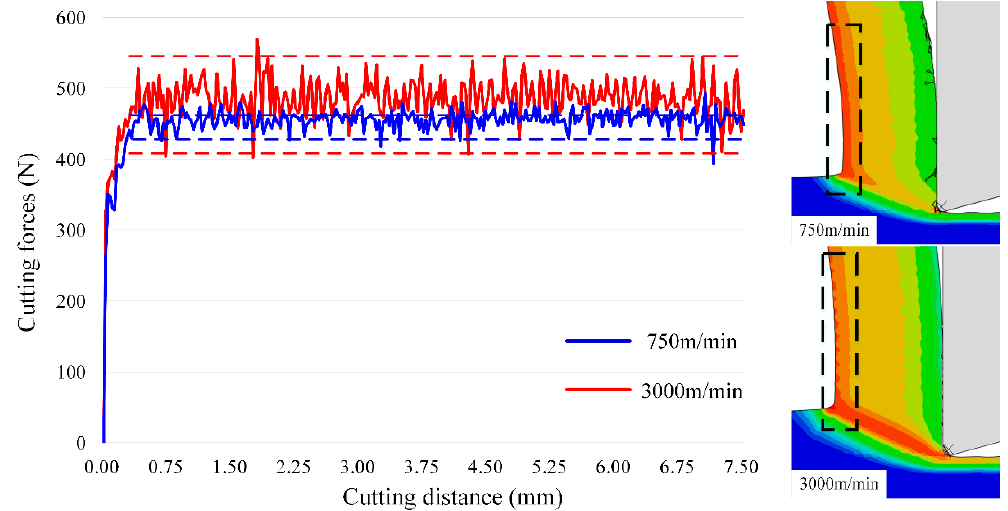
Figure 10. Fluctuation of cutting forces induced by the dislocation density evolution at different cutting speeds.